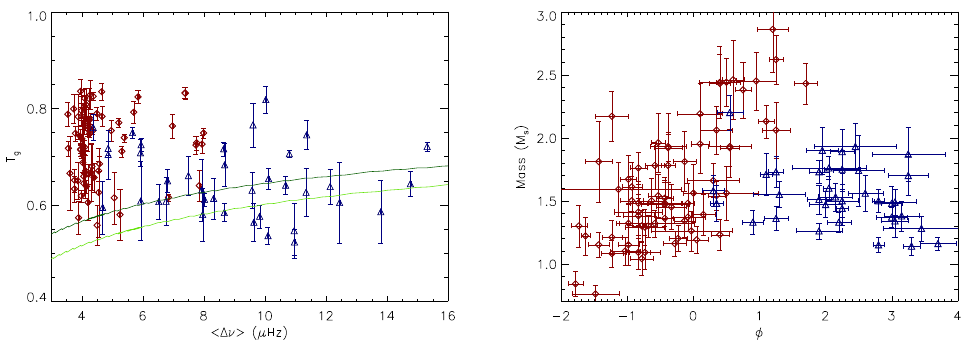
Fig. 1. Right : acoustic radius of the discontinuity related to the second helium ionisation zone as a function of the global large separation. Clump stars are indicated by red diamonds and RGB stars by blue triangles. Error bars correspond to 1- σ uncertainties. The light green line indicates the theoretical acoustic radius of the second helium ionisation zone for a 1 M (cid:4) star during the RGB phase. The dark green line gives the same information for a 1 . 4 M (cid:4) star. Left : stellar masses in function of the phase of the modulation. Error bars correspond to the 1- σ